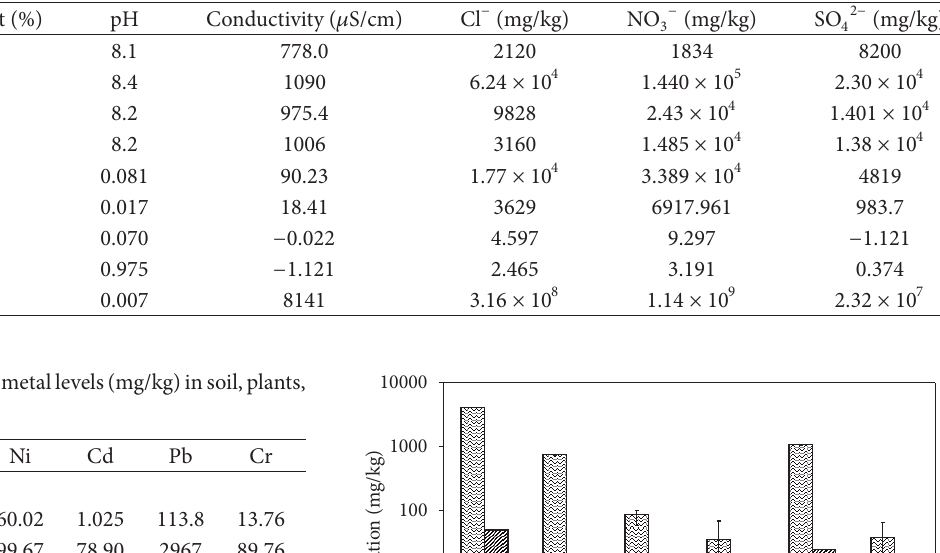
T 1: Descriptive statistics for physico-chemical parameters of soil samples (